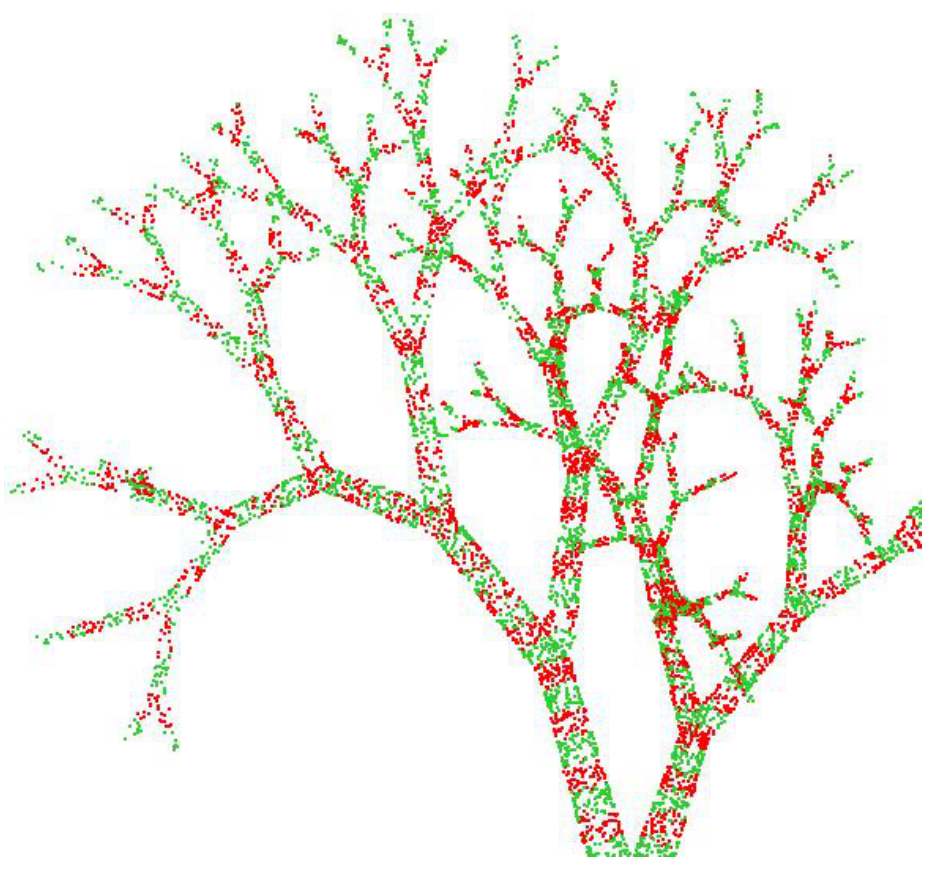
Figure 4. Point cloud segmentation using a level set value ( d ) of 0.09 m. Here, 50 levels were created and all tips ( i.e. , 128) were